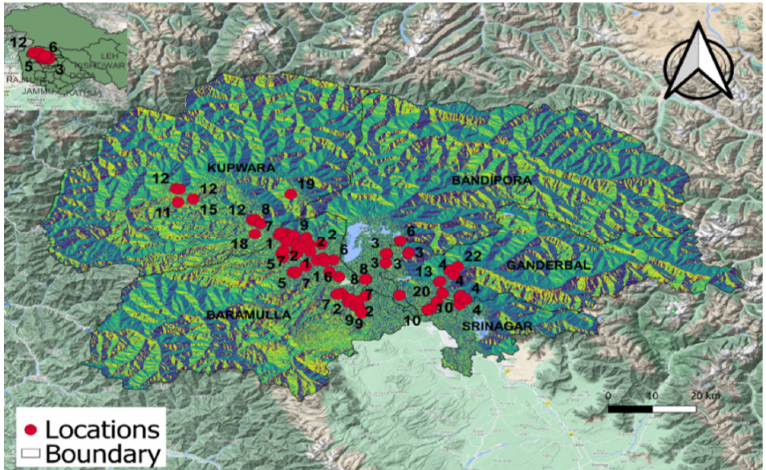
Figure 1. Study area map depicting distribution pattern of isolates of different Mycelial Compati- bility Groups.